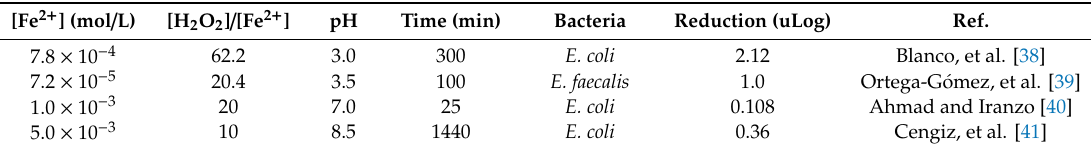
Table 4. Examples of Fenton technologies applied to the bacteria inactivation.